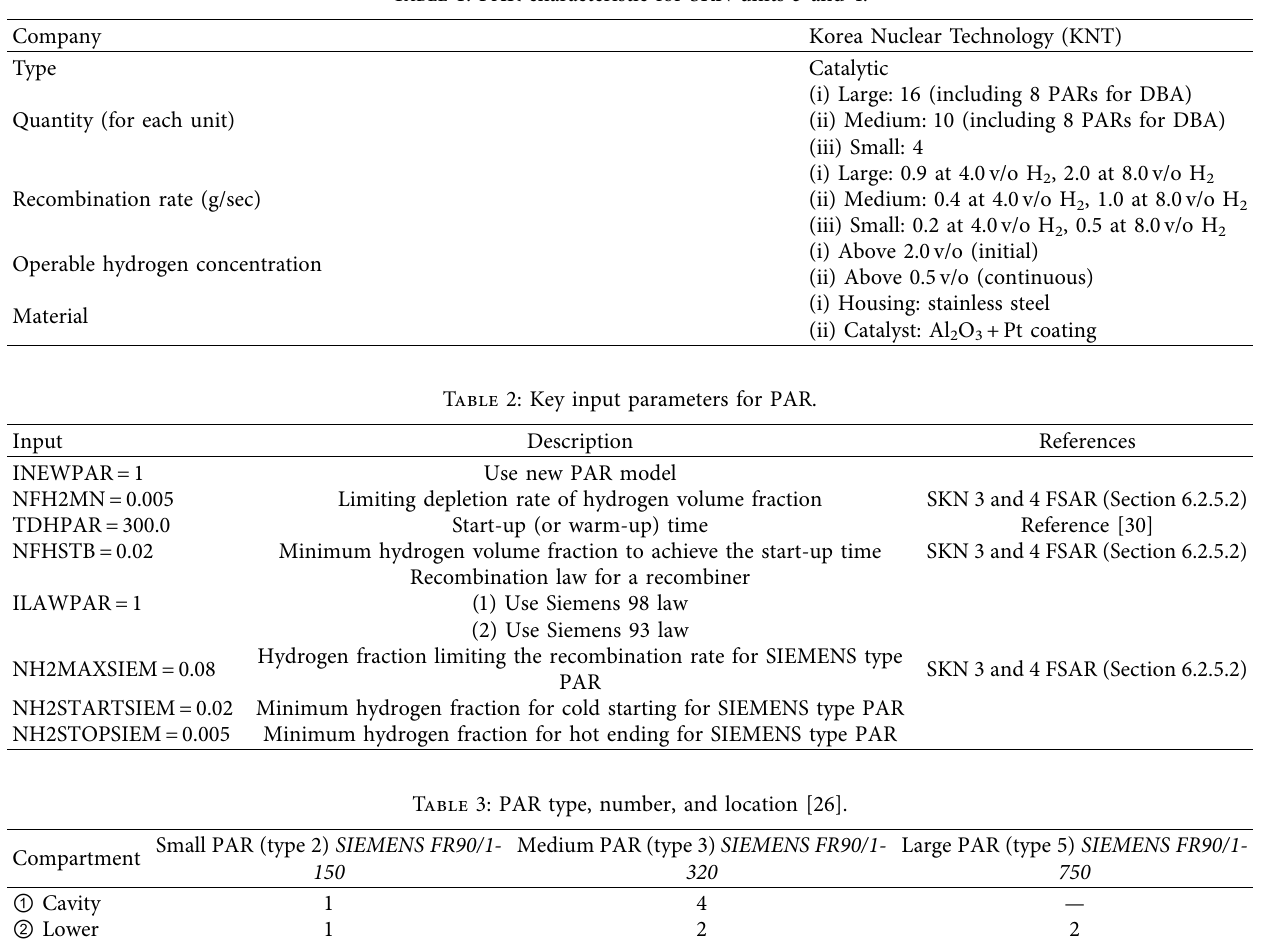
Table 1: PAR characteristic for SKN units 3 and